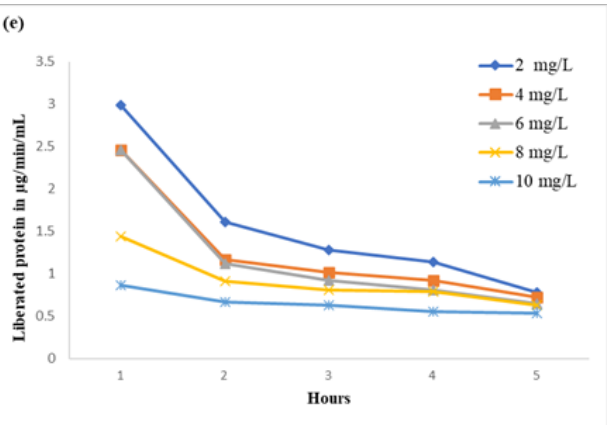
Figure 3. The effect of individual proanthocyanin extract on R-protease with different concentrations and times ( a ) FRL-50: Extract eluted in 50% methanol from Ficus religiosa , ( b ) FRL-DW: Extract eluted with distilled water from F. religiosa , ( c ) FR-50: Extract eluted in 50% methanol from F. racemosa , ( d ) FR-70: Extract eluted in 70% acetone from F. racemosa and ( e ) FR-DW: Extract eluted with distilled water from F. racemosa .